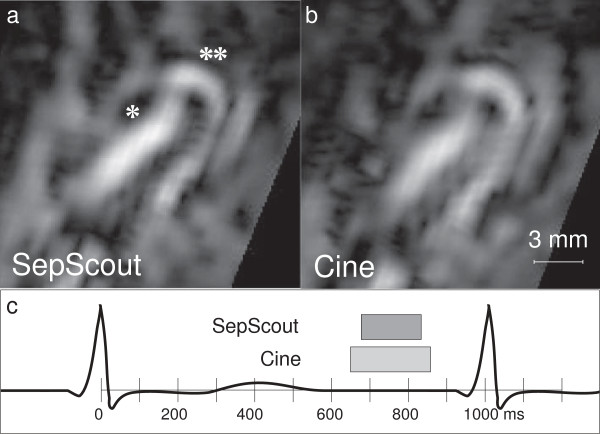
Image of a conus artery. Image of a conus artery (**) branching off of the proximal RCA (*) acquired during (a)Wsep, and (b)Wcine. A timing diagram illustrating gating windows of the two techniques is shown in (c).